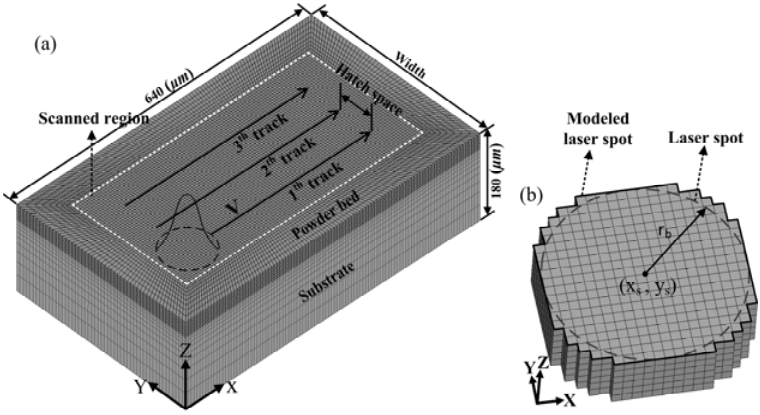
Figure 2. ( a ) 3D finite element model; ( b ) representation of the modeled laser spot. The modeled spot area is defined as Ω .